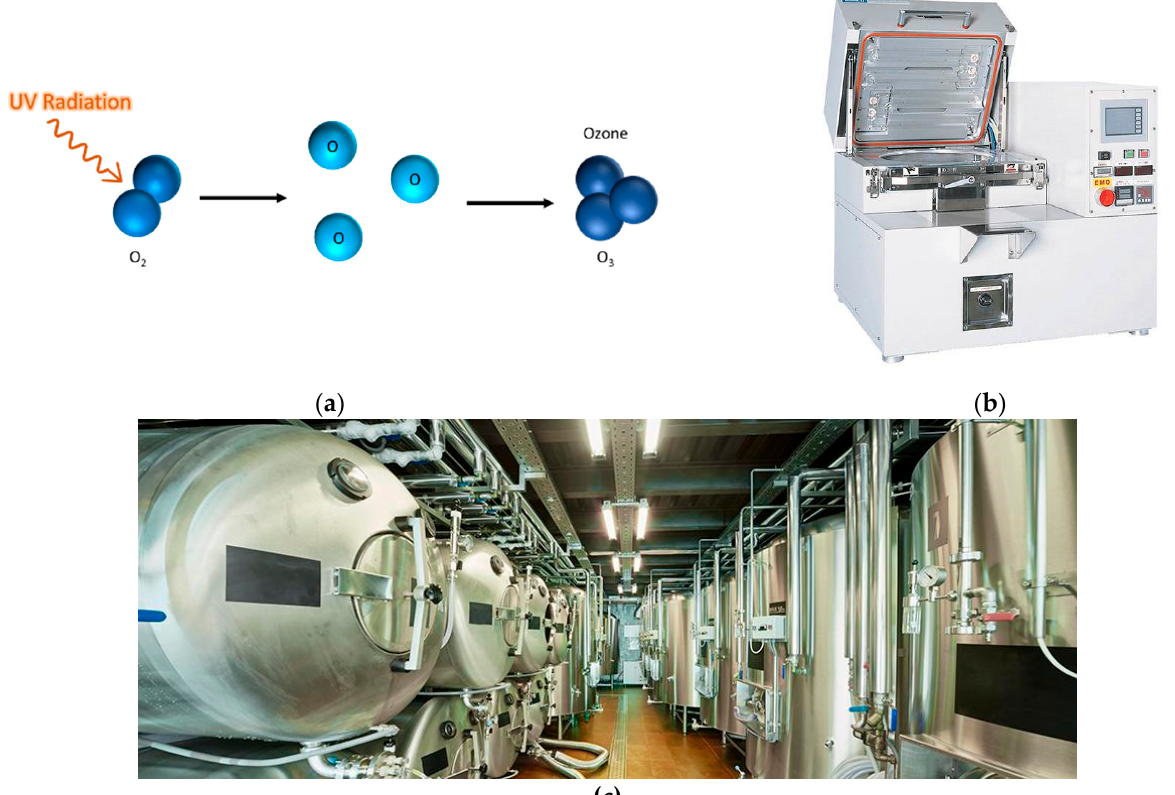
Figure 5. ( a ) Simplified scheme of the gamma ray initiation; ( b ) picture of a UV ‐ Ozone instrument designed for lab work Samco™ ; ( c ) picture of a brewing industry using UV ‐ ozone treatment Mellifiq™ .